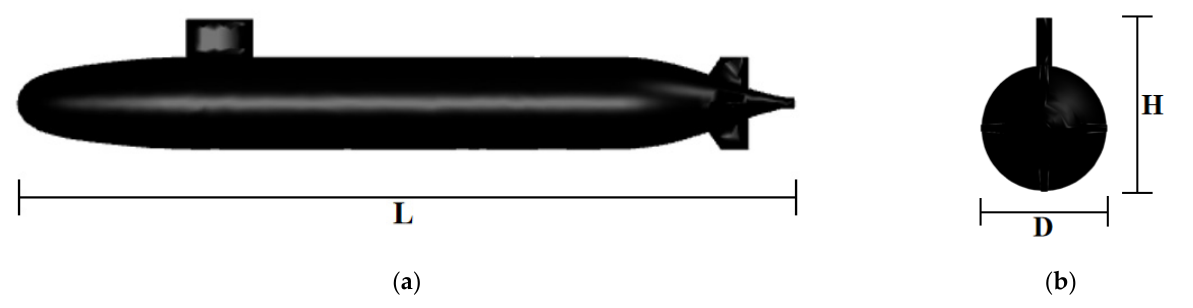
Figure 1. Main and side views of the SUBOFF submarine model. ( a ) Main view and ( b ) Side view. Table 1. SUBOFF scaling model parameters.